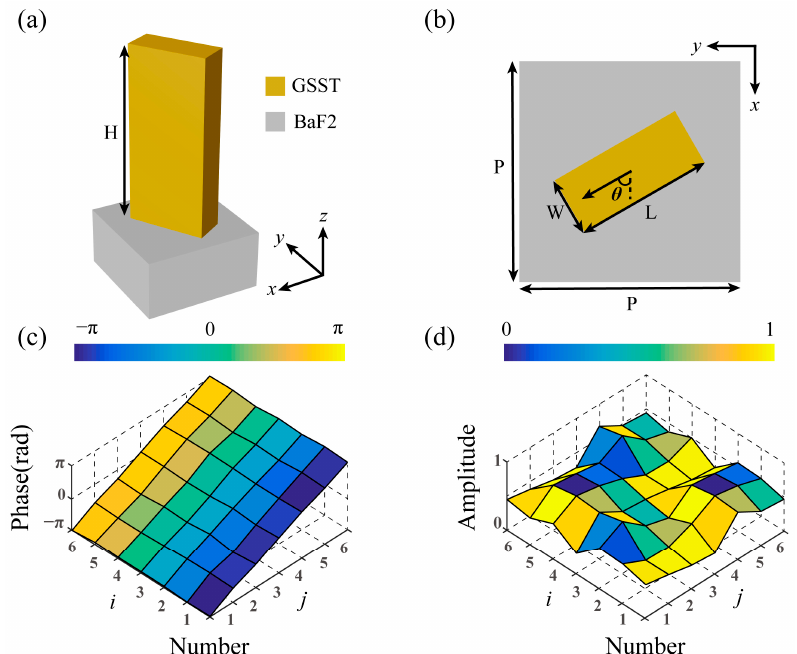
Figure 2. Simulated results for the meta atom. ( a ) Three-dimensional and ( b ) top view of the meta atom. ( c ) The simulated transmitted cross-polarized phase shift at A- and C-state. ( d ) The simulated transmitted cross-polarized amplitude at A- and C-state. i and j represent the number of the meta atom while the color of the pixel corresponds to the results at A-state and the position of each pixel indicates the results at